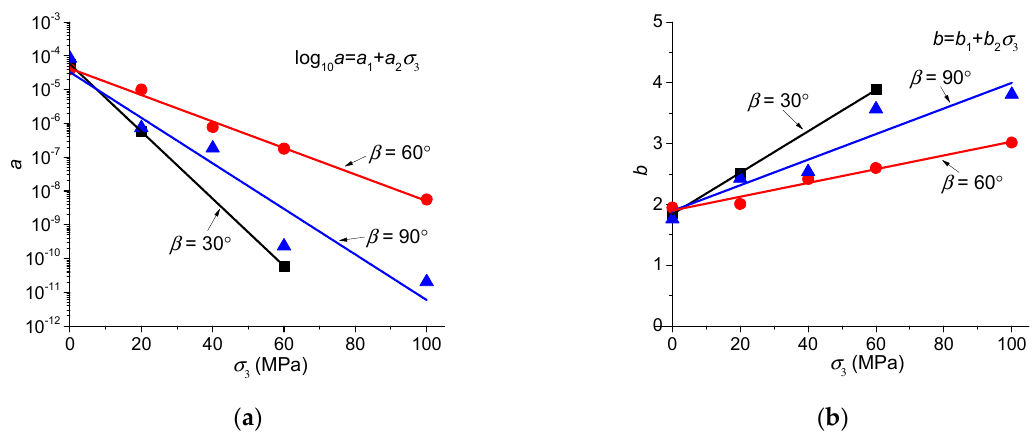
Figure 14. Fitting of constant parameters ( a ) a and ( b ) b dependent on the confining pressure σ 3 .